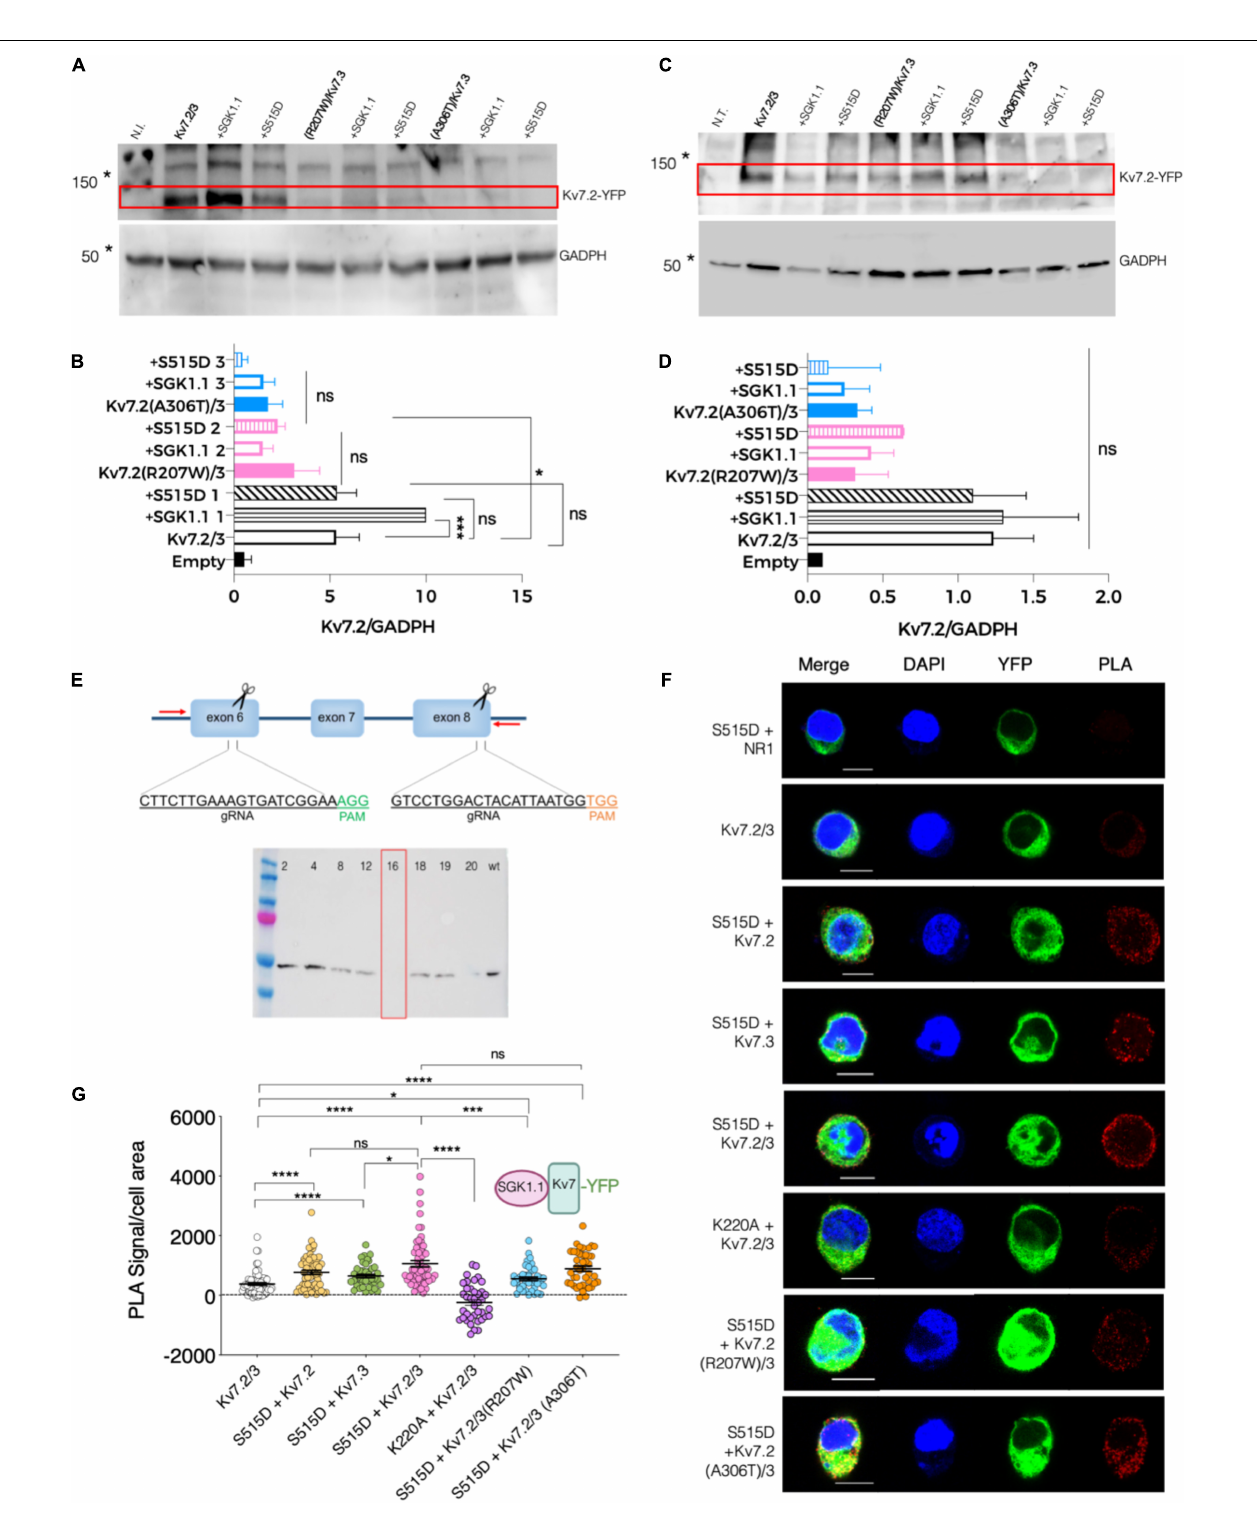
FIGURE 5 | Association between SGK1.1 (S515D) and heteromeric channel Kv7.2/3 is reduced in presence of epilepsy mutant Kv7.2 (R207W) but not Kv7.2 (A306T). (A) Representative immunoblot showing expression levels of Kv7.2 fused to YFP (top panel, 110 KDa) and GADPH (bottom panel, 50 KDa) from oocytes injected with the indicated constructs; N.I., water-injected oocytes. Asterisks denote migration of the indicated molecular mass marker. (B) Quantitative analysis of Kv7.2 expression levels in Xenopus oocytes. Values are mean ± SEM from at least three independent experiments (ANOVA Sidak’s test for multiple comparisons;